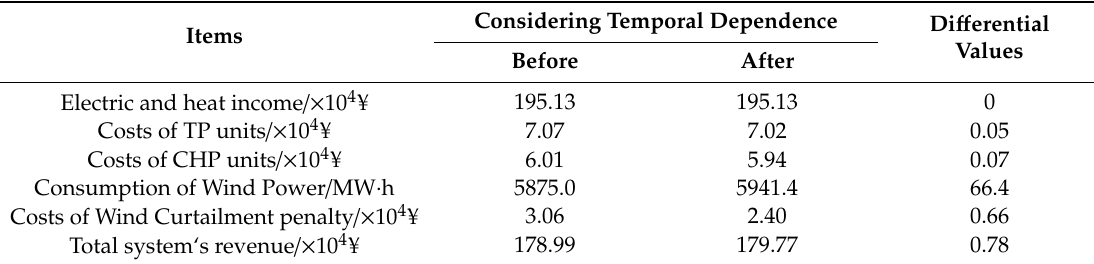
Table 1. The system’s revenue before and after considering temporal dependence.